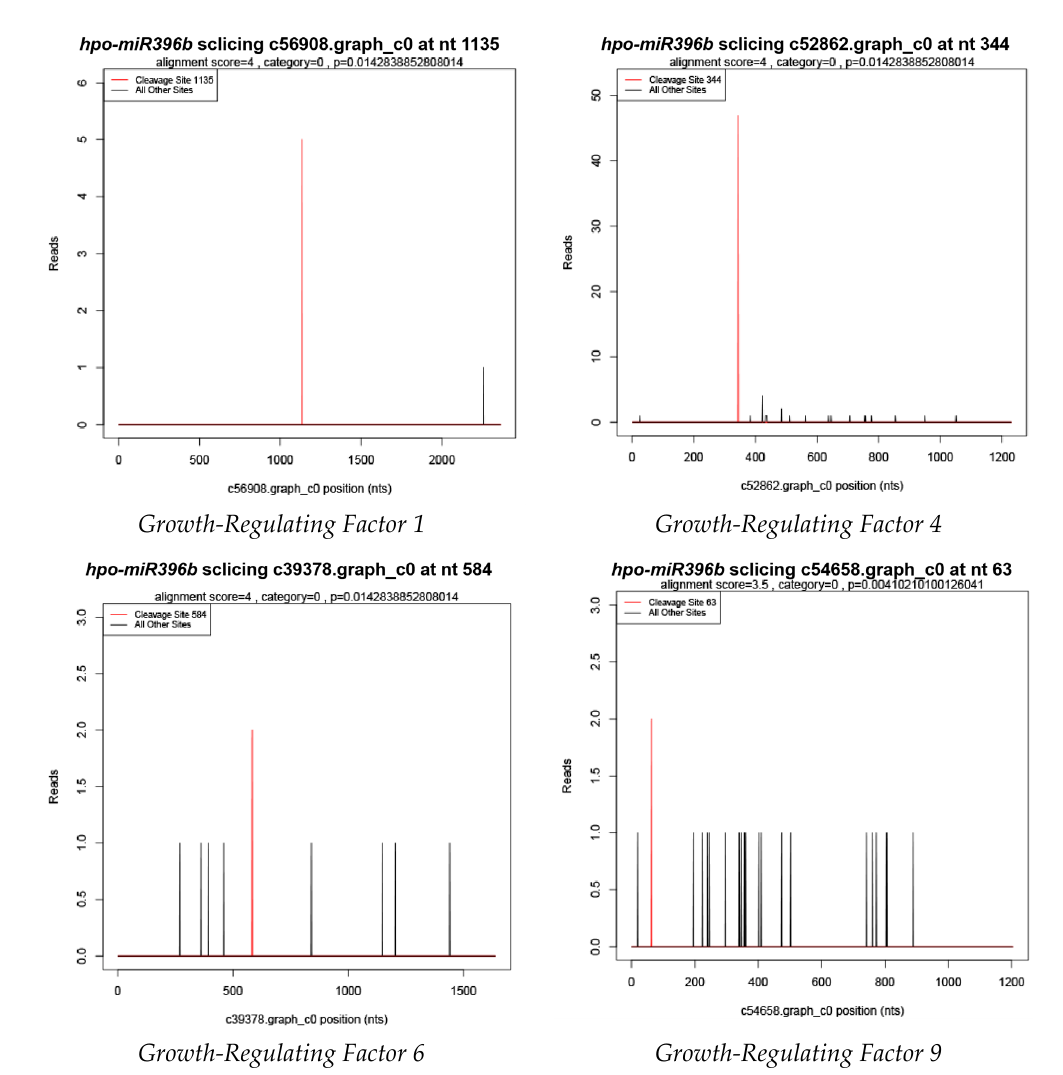
Figure 5. Target plot (t-plot) of target genes of the growth regulating factor ( GRF ) of hpo-miR396b gained by degradome sequencing. The red lines of t-plots indicate that the specific cleavage site. The X axis indicates the unigene. The y axis indicates the raw reads.